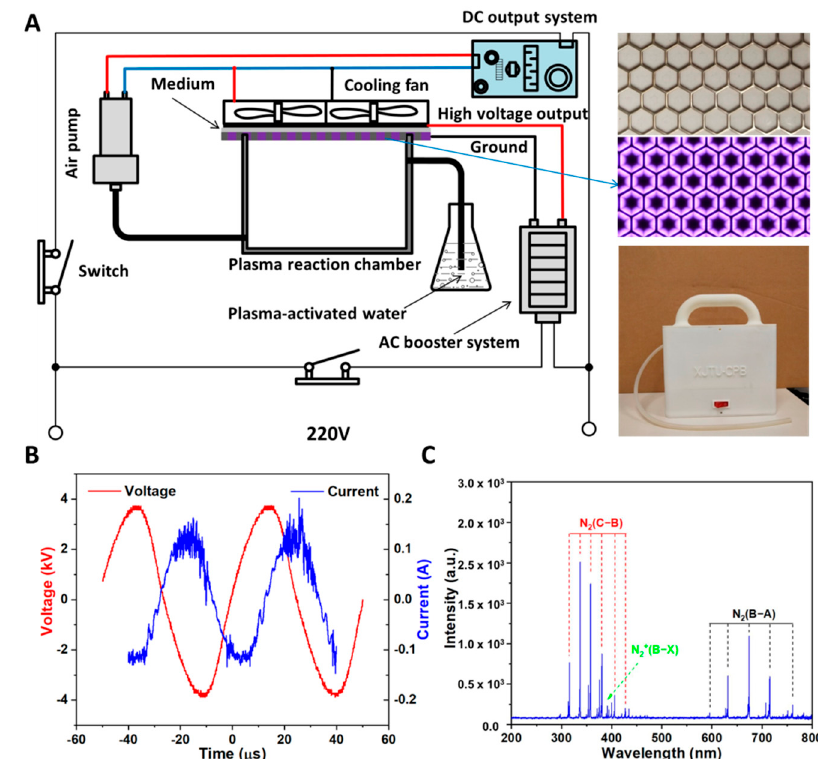
Figure 1. Experimental device and its electrical characteristics. ( A ) Internal schematic diagram, physical map, and discharge photo of the portable plasma device. ( B ) Waveforms of applied voltage and discharge current. ( C ) Emission spectrum of the surface discharge plasma.